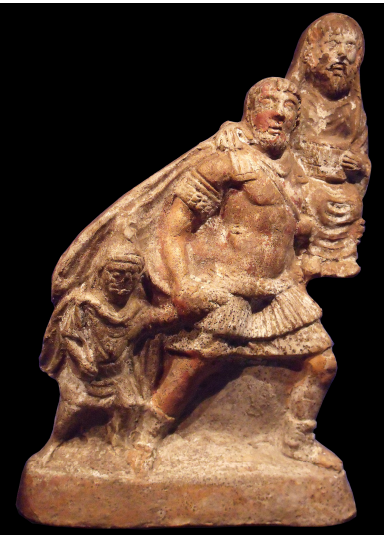
Figure 2. Aeneas carrying his father, Anchises, and his son, Ascanius. Terracotta figurine from Pompeii, 1st century CE. National Archaeological Museum, Naples, Italy. Accession Number: Inv. 110338. Photo Source: Alphanidon. (Creative Commons Licence: CC BY-SA 3.0. https://upload. wikimedia.org/wikipedia/commons/2/2a/Terracotta_Aeneas_MAN_Naples_110338.jpg accessed date: 2 January